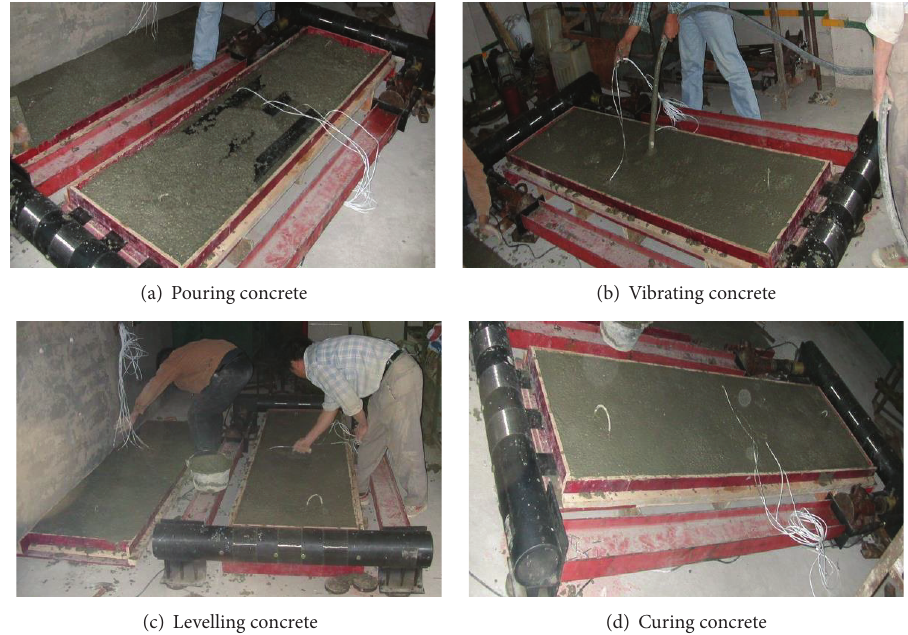
Figure 8: Construction process of the concrete slab.